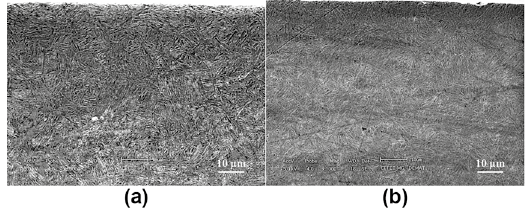
Figure 4. Micrographs of samples grinded with Soybean pure (A) and Soybean 5 (B).